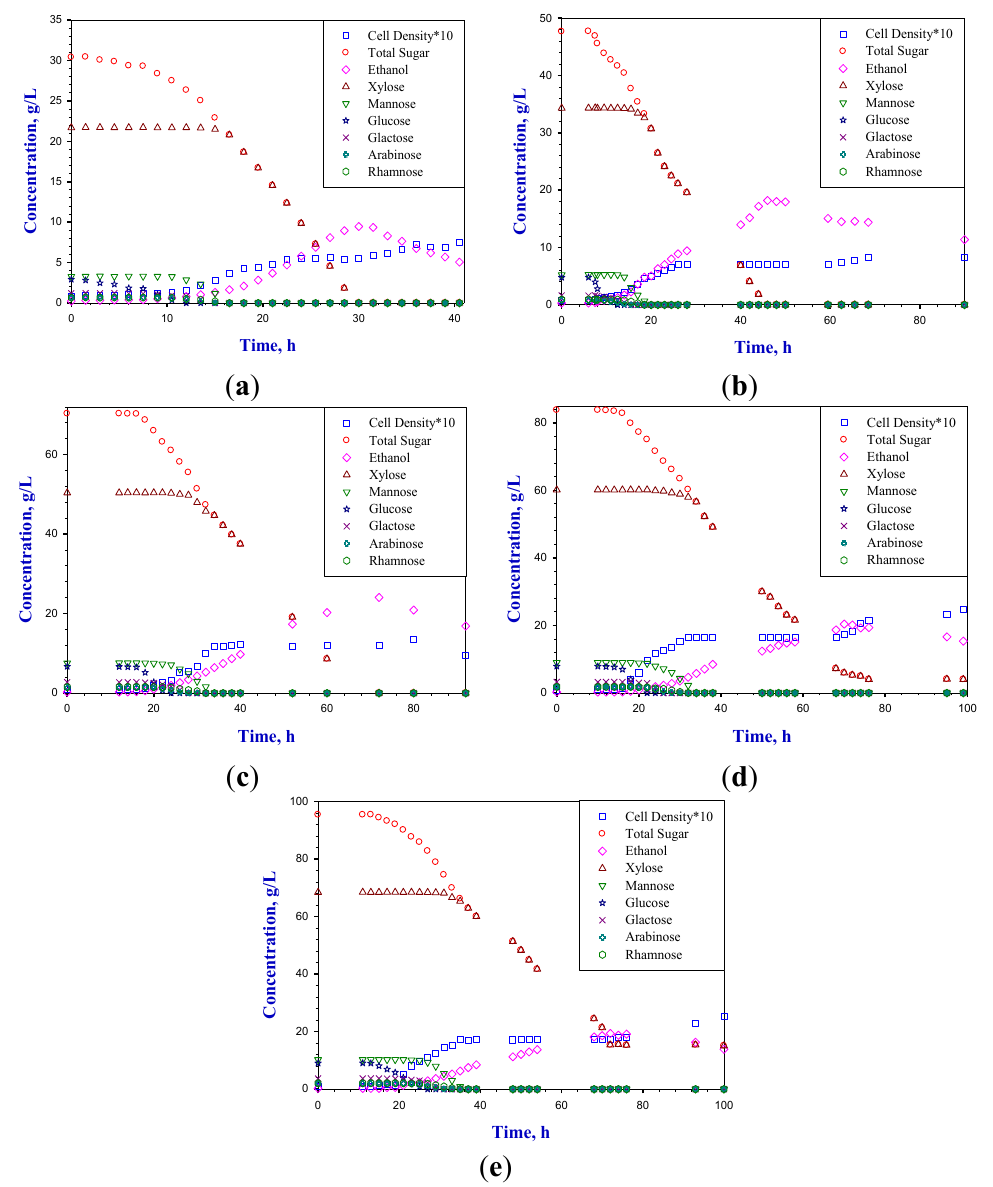
Figure 1. Time courses of recombinant E. coli FBWHR growth, total and